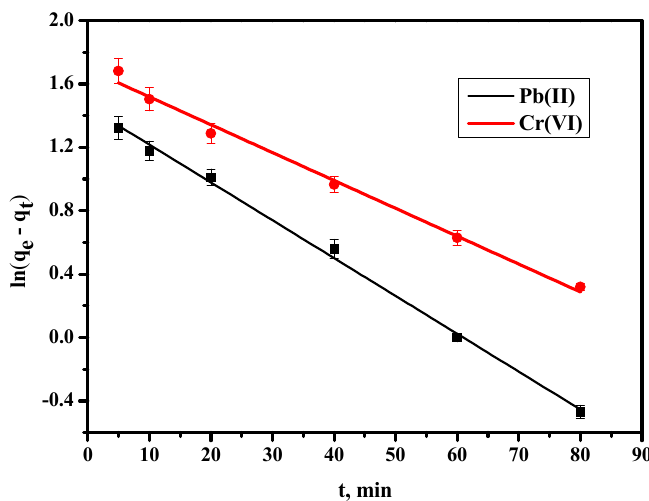
Figure 8. Linear fit of experimental data obtained using pseudo-first order kinetics model (adsorbent mass: 0.80 g/100 mL for Pb(II) at pH 4.6 and 1.00 g/100 mL for Cr(VI) at pH 4.0; metal ion concentrations: 50 mg/L for Pb(II) and 70 mg/L for Cr(VI); temperature: 25.0 °C).